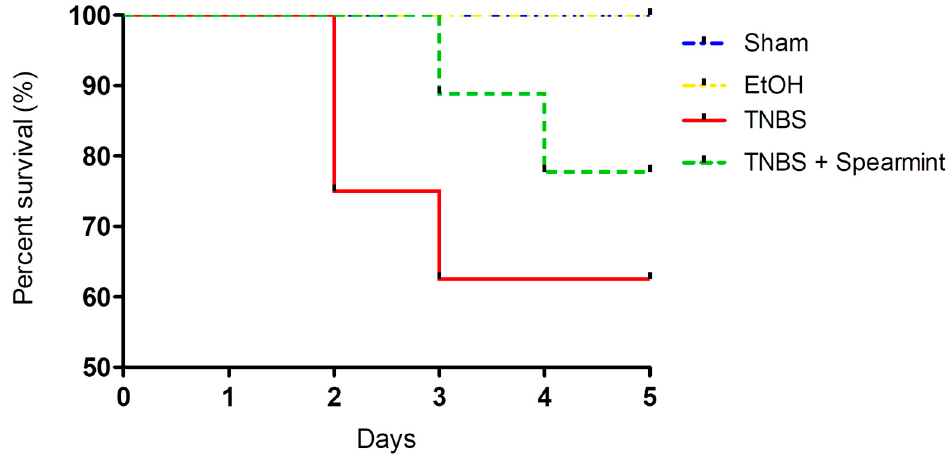
Figure 4. Comparison of survival curves between the four groups tested in the in vivo colitis model.